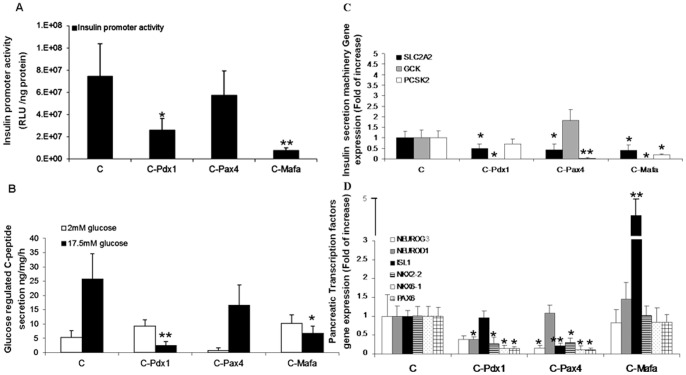
The individual role of the pancreatic transcription factors in the transdifferentiation process.Adult human liver cells were treated by the direct “hierarchical” sequential infection order (C, Figure 3A). One single transcription factor (pTF) was omitted at a time and replaced by an identical MOI of Ad-CMV-β-gal. Pdx1 omission is indicated as (C-Pdx1), Pax4 omission is indicated as (C-Pax4), and Mafa omission is indicated as (C-Mafa). (A) Insulin promoter activation analysis, results are presented mean ± SE, *p<0.1, **p<0.05 compared to the direct “hierarchical” sequential infection order (C). n≥6 in 3 independent experiments preformed in cells isolated from different donors. (B) C-peptide secretion was measured by static incubation for 15 min at 2 and 17.5 mM glucose in KRB. *p<0.05, **p<0.01 compared to the direct “hierarchical” sequential infection order (C). n≥6 in 3 independent experiments. (C–D) Quantitative Real-Time PCR analysis for the transcription levels of pancreatic enzymes (C) and pTFs (D). CT values are normalized to β-actin gene expression within the same cDNA sample. Results are presented as relative levels of the mean±SE compared to “hierarchy sequential infection” treated liver cells. *p<0.05, **p<0.01, n≥6 in 3 independent experiments preformed in cells isolated from different donors.